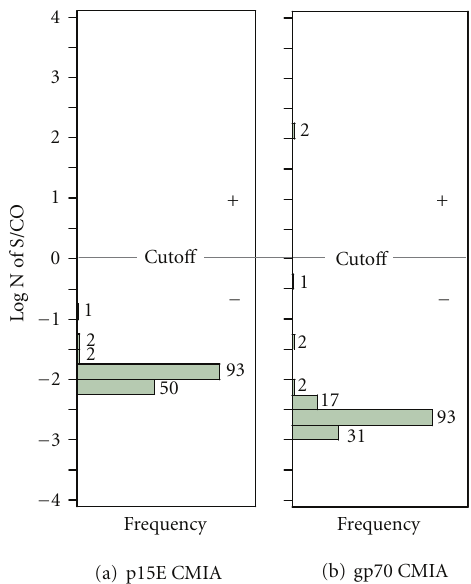
Figure 1: Distribution of p15E CMIA (a) and gp70 CMIA (b) log N of S/CO on 148 samples collected from 112 CFS patients and 36 healthy controls. Numbers of specimens within each log N of S/CO value are shown above the solid bars. Assay cuto ff s were equivalent to mean 16 SD and 12 SD for p15E and gp70 CMIAs, respectively, based on blood donor populations [22]. Log N of S/CO, natural log transformation of S/CO.